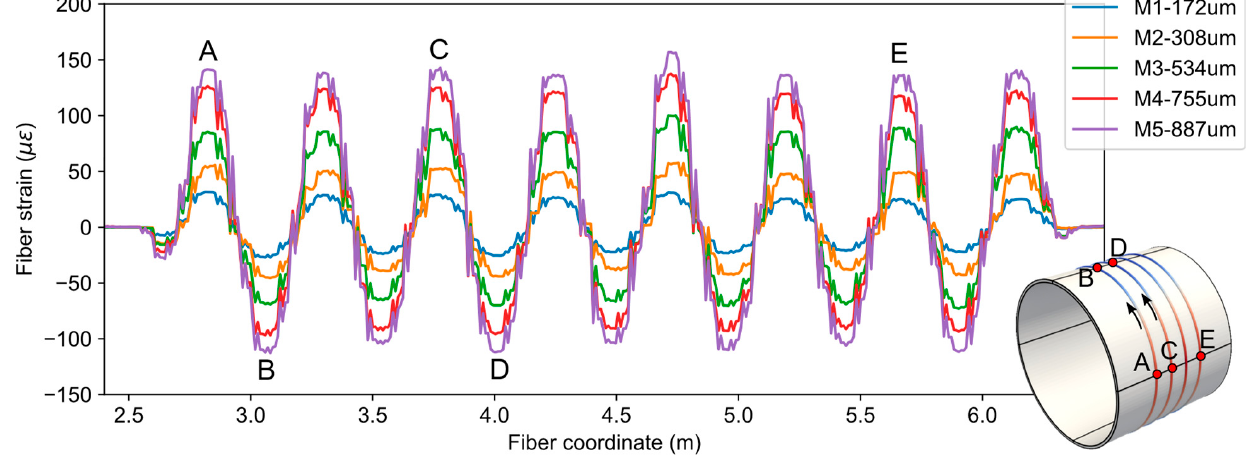
Figure 8. Fiber strain measurement data from experiments.